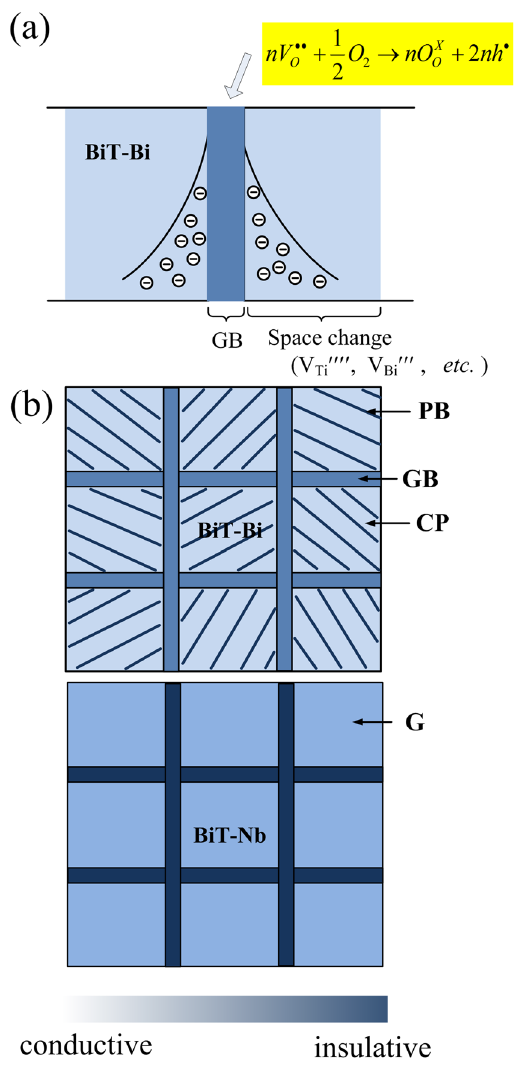
Figure 11. Schematic illustrations of ( a ) formation of the barrier layer at the grain boundary region ( b ) electrical microscopes of BiT-Bi and